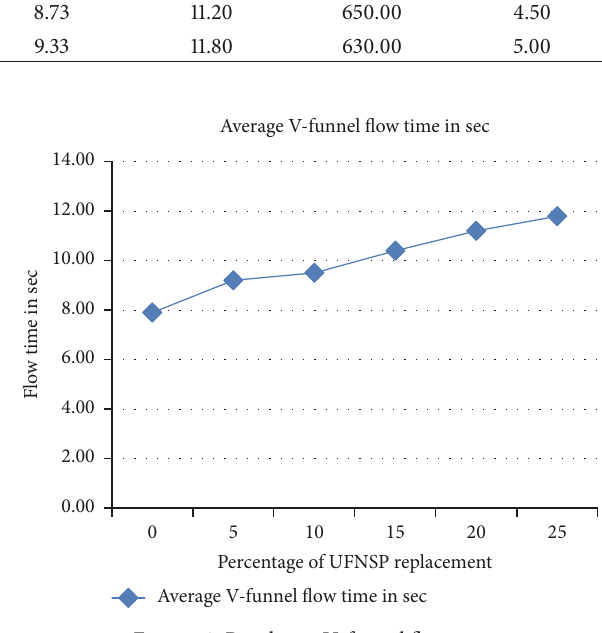
Figure 3: Results on V-funnel flow